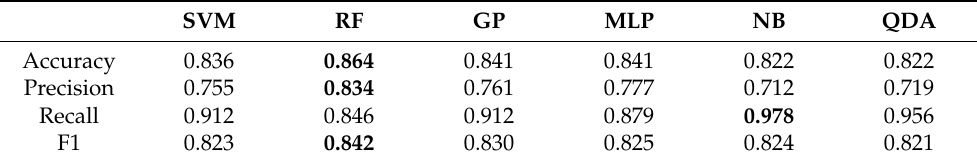
Table 6. Performance of different ML models when trained on laboratory images and tested on unseen laboratory images. The best performer in each row is shown in bold.